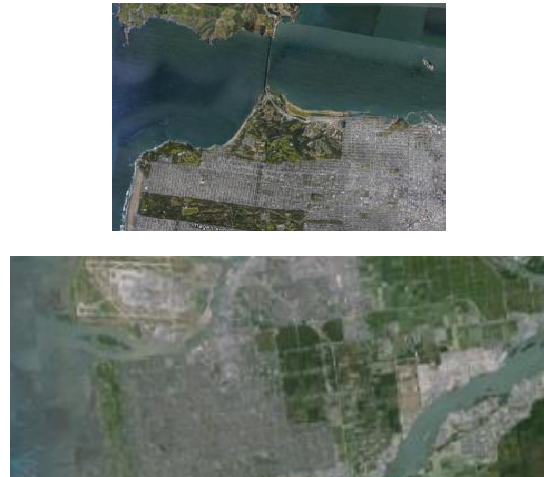
Fig.1. Google earth images of the study areas, San Francisco (Left), Vancouver